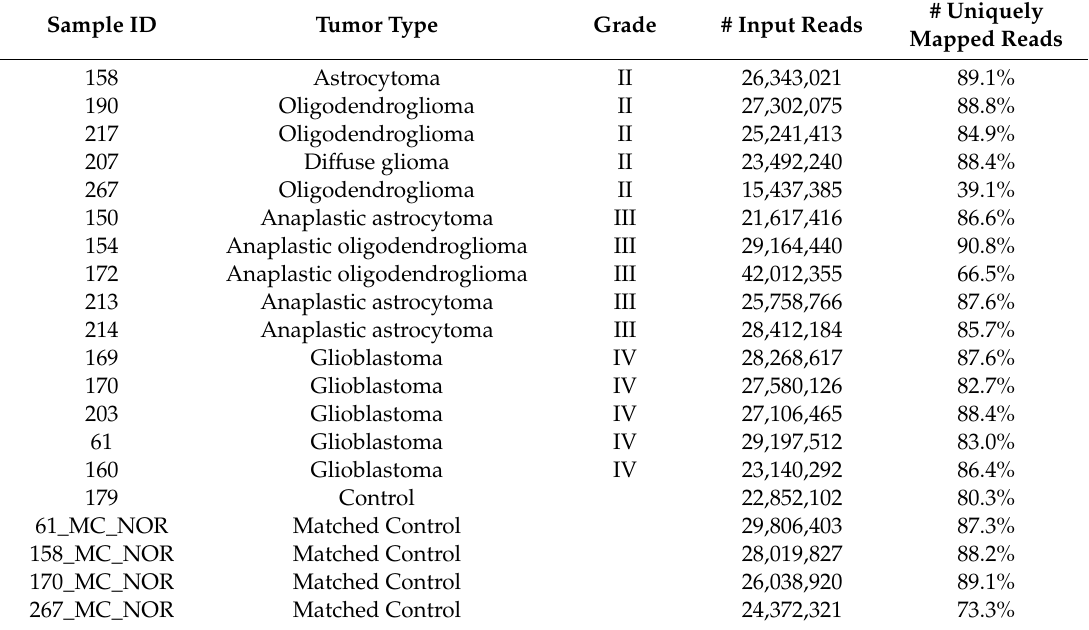
Table1. SampleID,tumortypeandgrade, RNAsequencingreadandalignmentstatistics. Tumorsample ID #267 (colored in red) was excluded from RNA seq analysis due to low percentage mapped